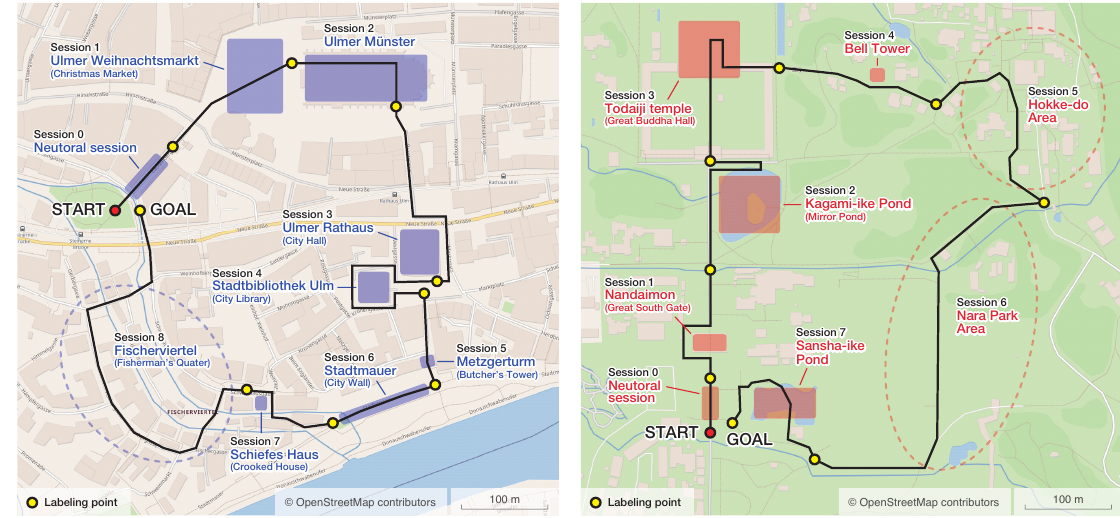
Figure 8. Experimental fields.